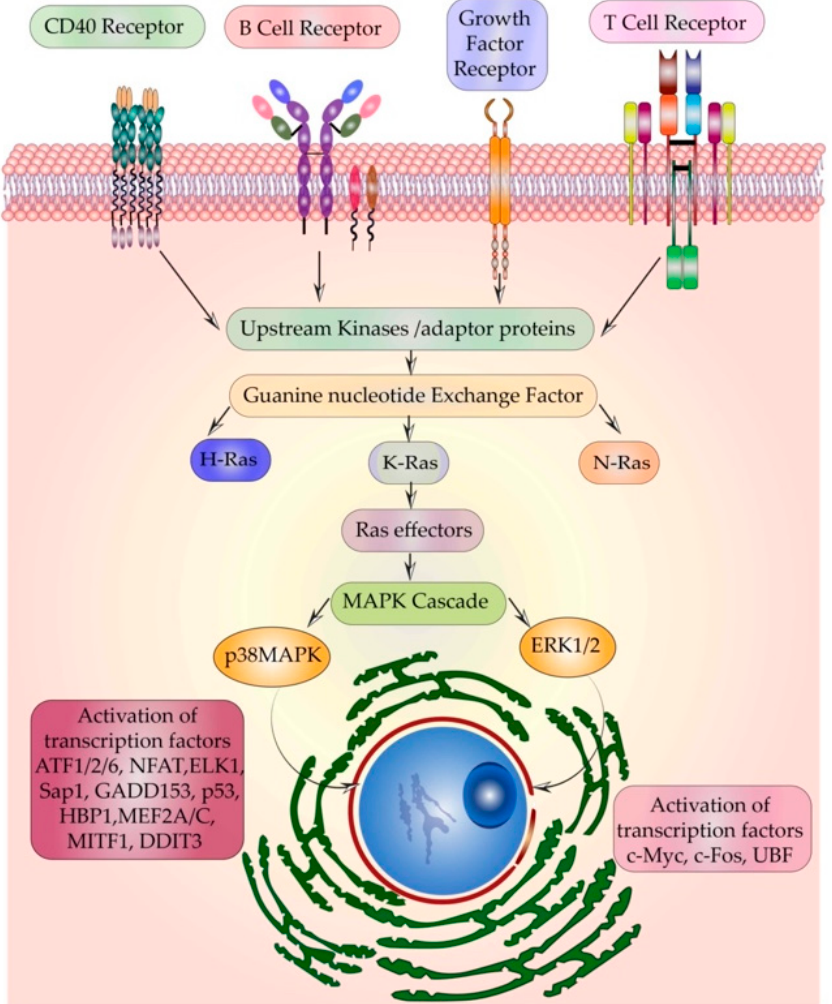
Figure 5. Ras is activated not only by receptor tyrosine kinases but also by receptors enriched on immune cells like B cell receptor, T cell receptor, CD40 receptor, and certain Toll-like receptors. On receptor ligation, the signal relay occurs through upstream kinases or adaptor proteins that activate guanine nucleotide exchange factors (GEFs). Ras isoforms have activator specificities that are context-dependent. Once activated H, K and N-Ras activate specific effectors that contain- Ras-binding domain (RBD). The signal is further relayed downstream via MAPK cascades which leads to activation of transcription factors and hence cellular